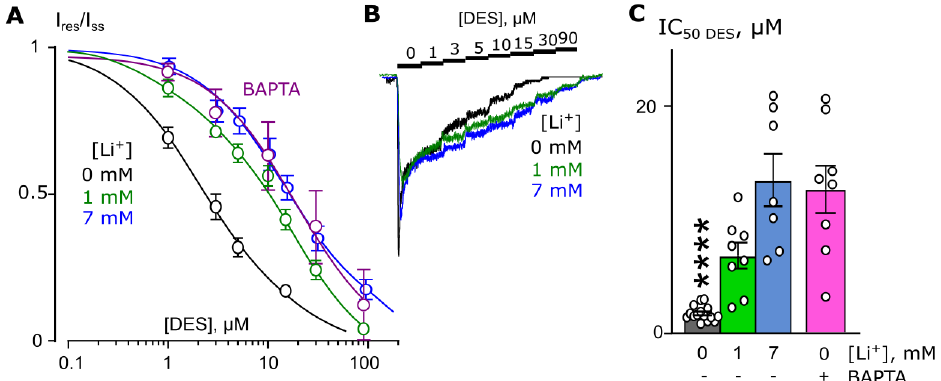
Figure 3. Extracellular lithium effect on desipramine (DES) inhibition of NMDAR currents in the bathing solution containing 1 mM [Ca 2+ ]. ( A ) Dependence of IC 50 for DES inhibition of NMDAR currents on extracellular [Li + ]. Symbols show mean values ± S.E.M of the relative amplitudes of currents (I b /I c ) in the presence (I b ) and absence (I c ) of different DES concentrations ([DES]). Solid lines are the fits to the data with the Hill equation. ( B ) Examples of currents activated by 100 µ M NMDA + 30 µ M Gly recorded at − 70 mV in the presence of increasing [DES] in control bathing solution and in 1 mM or 7 mM [Li + ]. [DES]s are indicated by numbers at the corresponding level of currents (in µ M). Currents are normalized to the steady-state amplitude without DES. ( C ) Mean IC 50 s for DES inhibition of NMDAR currents in control, in the presence of different [Li + ]s, and in neurons loaded with BAPTA. Data in control differ significantly from those in the presence of 7 mM [Li + ] or in BAPTA-loaded neurons (****, p = 0.00001, one-way ANOVA). Data from each experiment (symbols) and mean values ± S.E.M. are shown.